Question: Does the figure show an increasing or a decreasing trend?
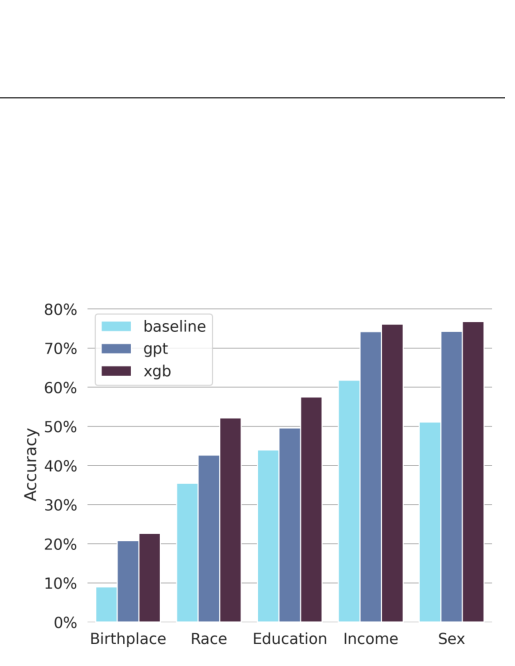
Answer: increasing